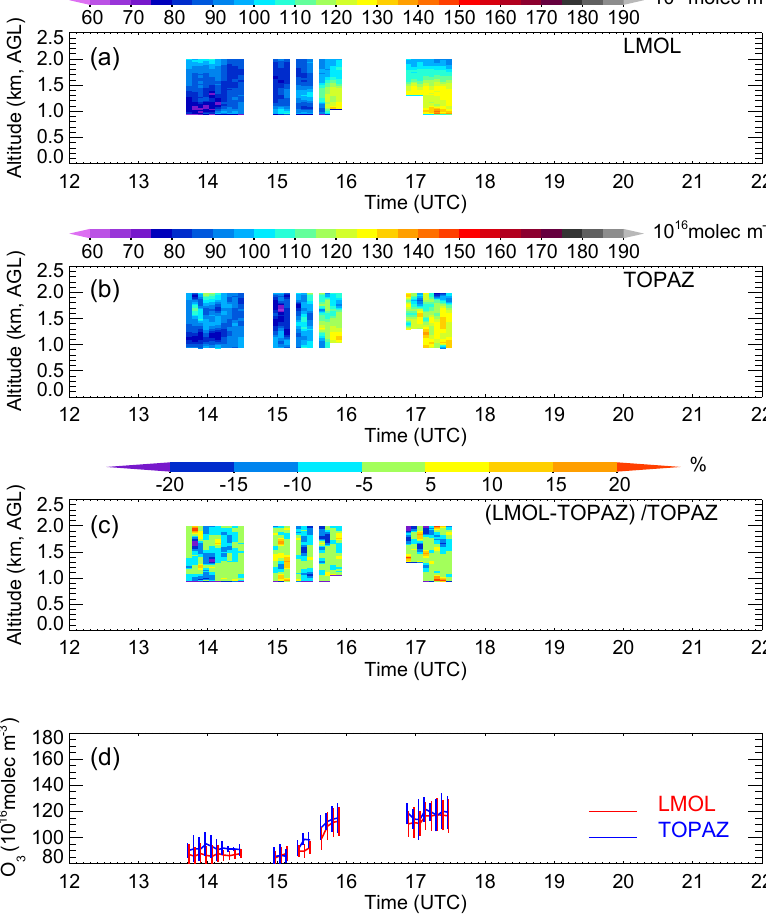
Figure 2. Comparisons of ozone measured by LMOL and TOPAZ. (a) LMOL-measured ozone number densities. (b) TOPAZ-measured ozone number densities. (c) Their relative percent differences, (LMOL–TOPAZ)/TOPAZ. (d) Column averages measured by LMOL and TOPAZ as well as their 1 σ standard deviations. LMOL measures 3 . 8 ± 2 . 9% lower ozone column average than